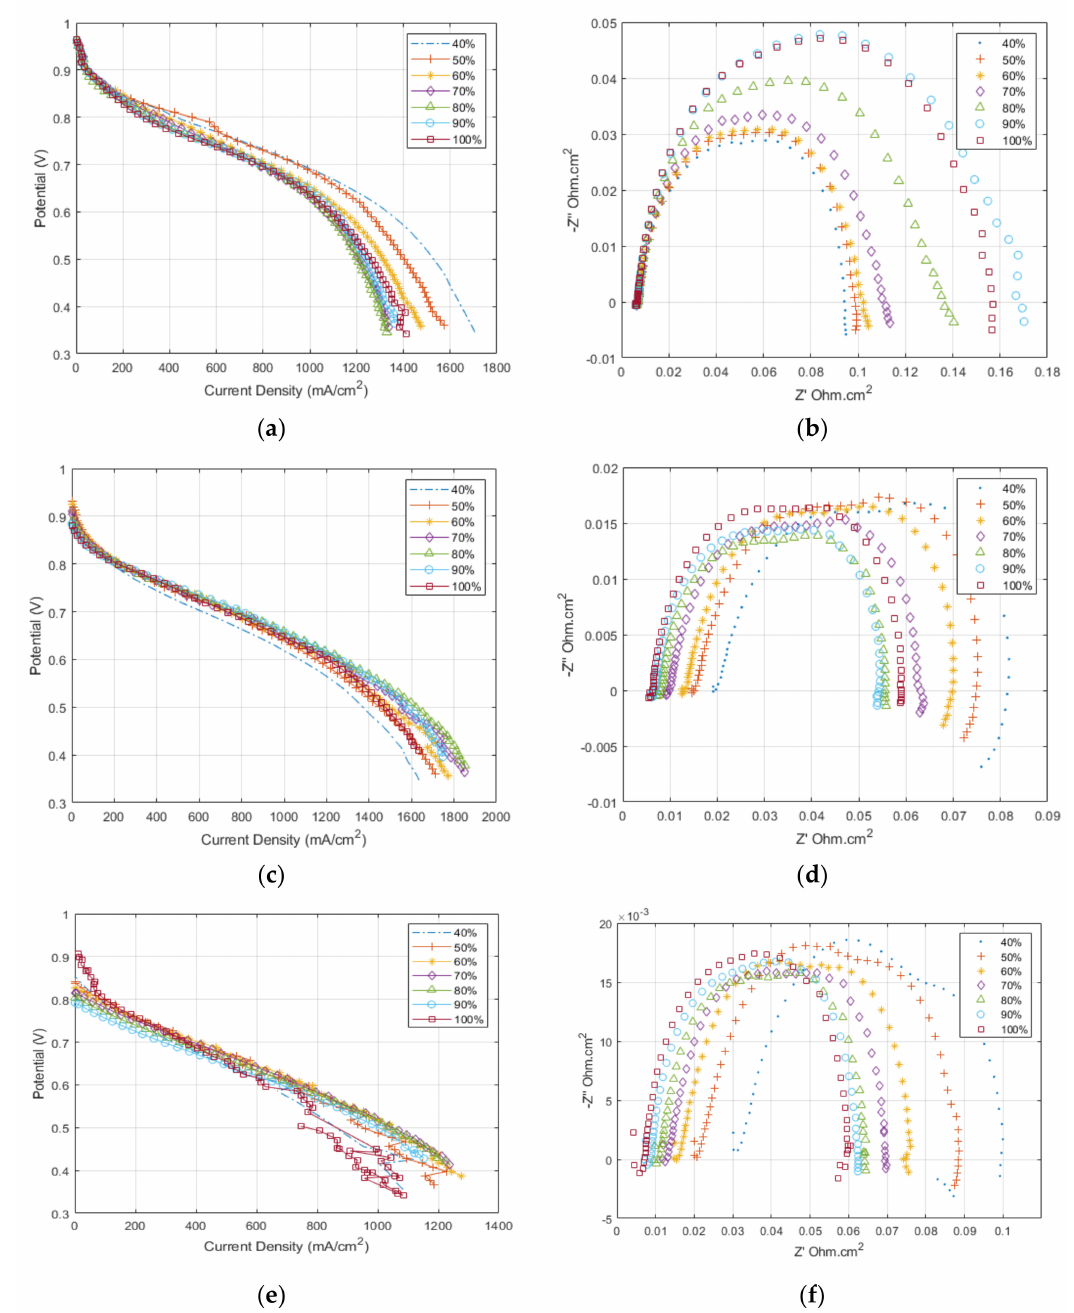
Figure 3. Polarisation curves at different temperatures ( a ) 80 ◦ C, ( c ) 100 ◦ C, and ( e ) 120 ◦ C and Impedance spectroscopy at 0.5V over different temperatures ( b ) 80 ◦ C, ( d ) 100 ◦ C, and ( f ) 120 ◦ C, data is separated by relative